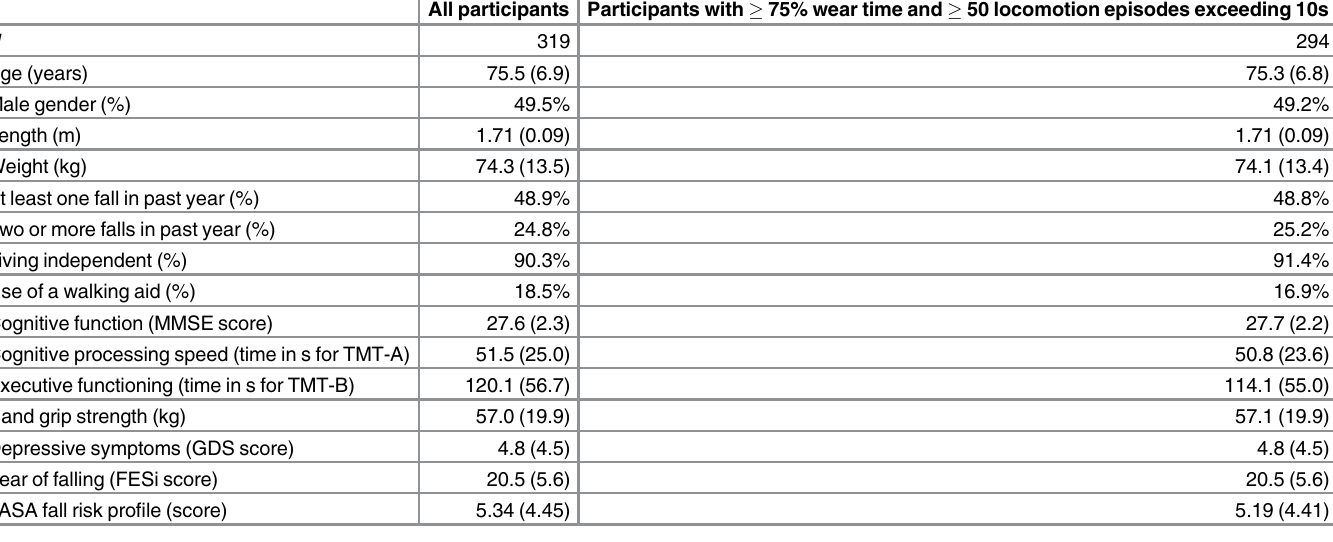
Table 1. Baseline characteristics of the